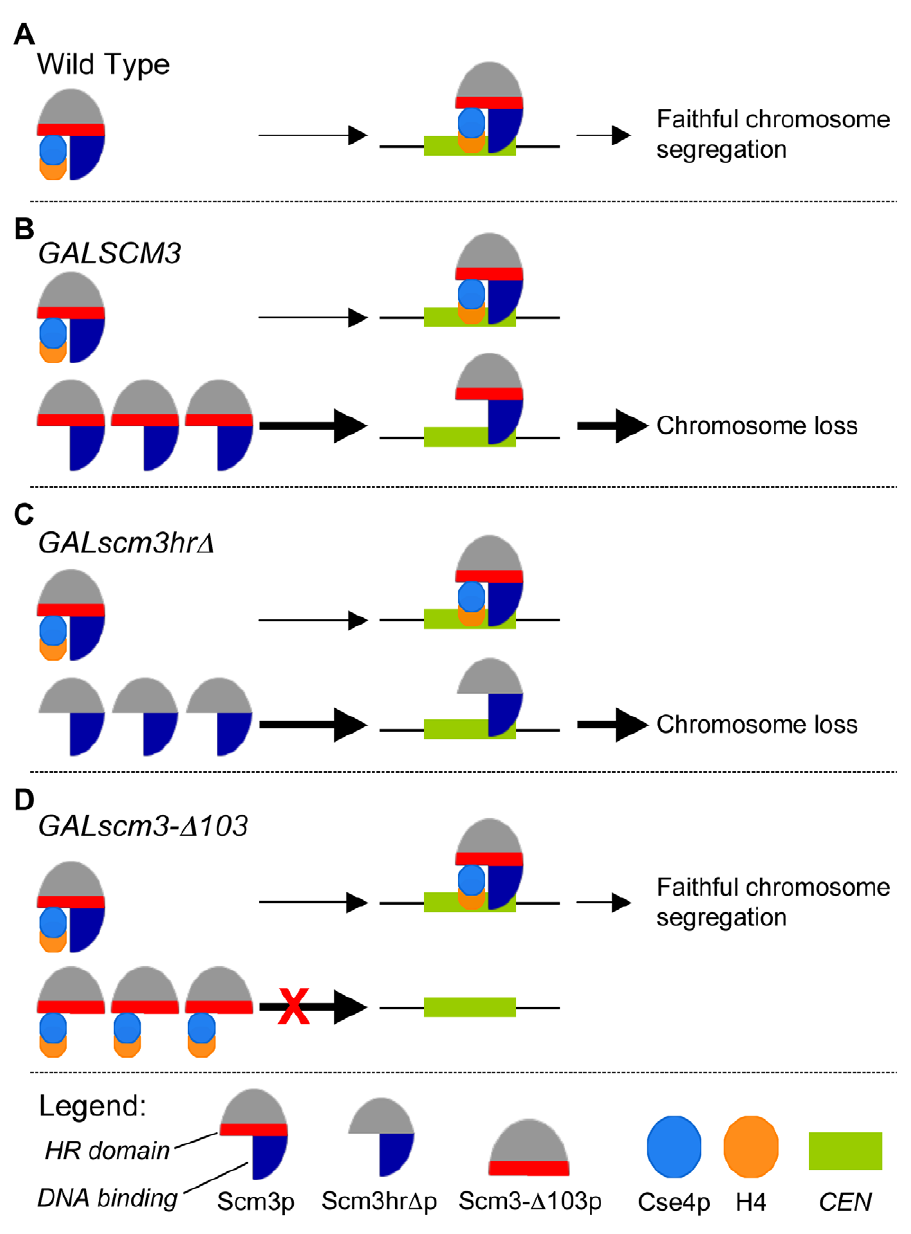
Figure 8. Schematic model for GALSCM3 -induced chromosome instability in budding yeast. (A) In wild type cells, Scm3p forms a stoichiometric complex with Cse4p/H4 tetramers and mediates the assembly of Cse4p at the CEN DNA resulting in faithful chromosome segregation. (B) Centromeric association of Scm3p devoid of Cse4p contributes to the chromosome loss phenotye of GALSCM3 strains. In GALSCM3 expressing cells, there is an excess of Scm3p compared to the available pools of Cse4p and H4. Centromeric association of Scm3p devoid of Cse4/H4 leads to chromosome loss. Support for this is based on chromosome loss, ChIP experiments and suppression analysis from Figure 1. (C) Scm3p devoid of Cse4p can associate with centromeric DNA. GALscm3hr D that cannot interact with Cse4p can bind CEN DNA and association of Scm3p devoid of Cse4p leads to the chromosome loss phenotype of GALscm3hr D strains (Figure 5). (D) The N-terminus of Scm3p defines the centromeric association domain of Scm3p. Overexpression of scm3 mutants ( GALscm3- D 103 ) that can interact with Cse4p but do not associate with CEN DNA do not exhibit increased chromosome loss (Figure 5). Thick arrows represent excess Scm3p or its allelic mutant forms. Taken together our data support the model that centromeric association of Scm3p devoid of Cse4p contributes to the chromosome loss phenotype of GALSCM3 strains.